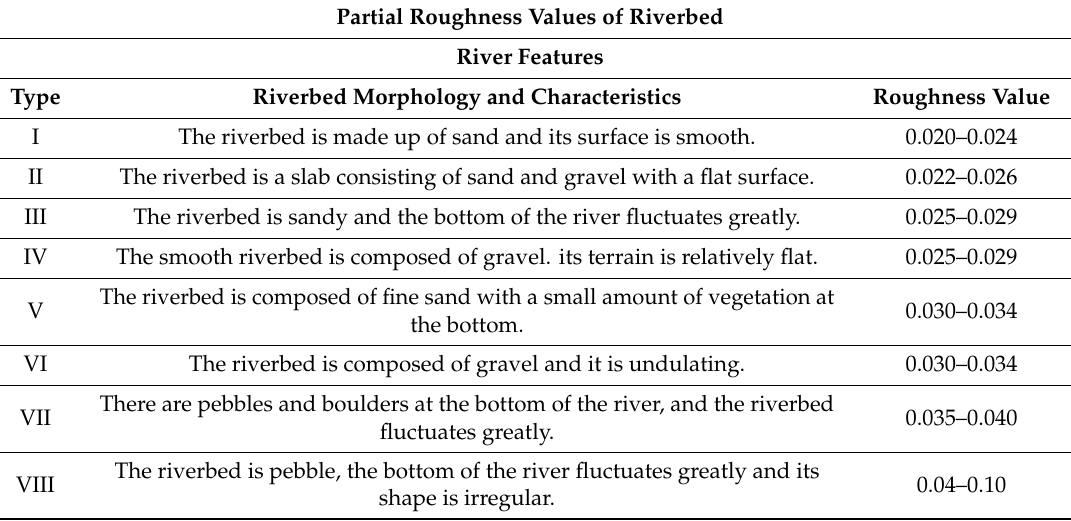
Table 1. Partial roughness values of